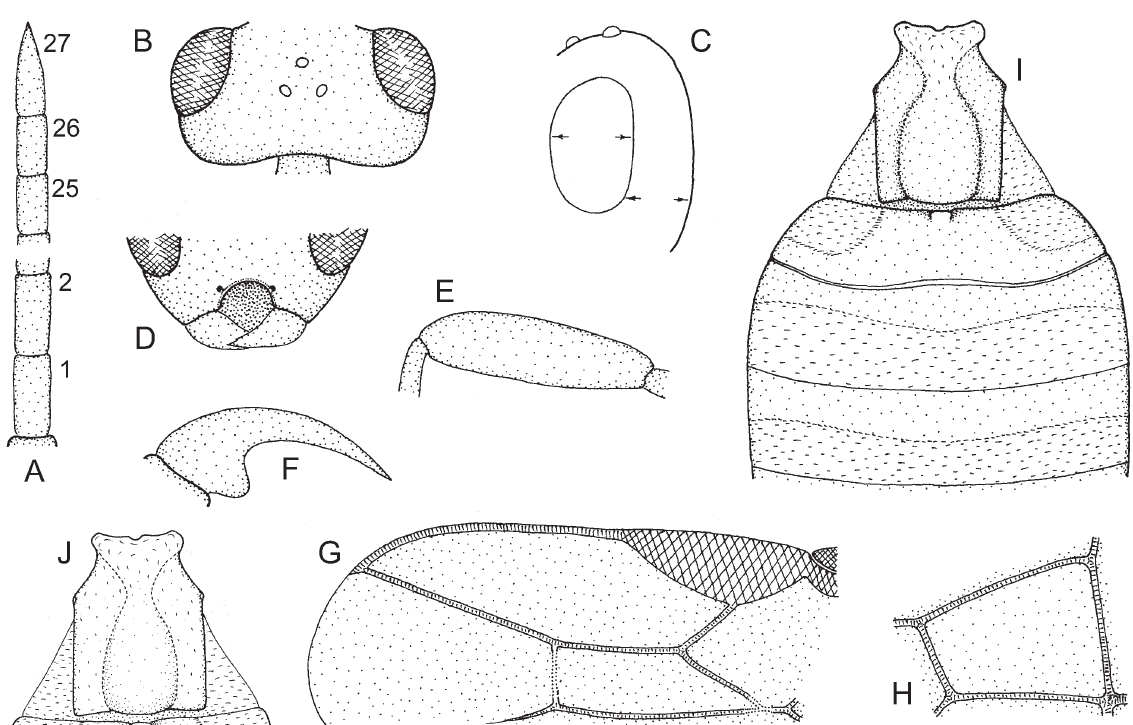
Fig. 65. Bracon ( Osculobracon ) osculator Nees, 1811 (A-I: ♀ neotype, B. bisignatus Wesmael, 1838, J: ♀ paralectotype). A . Flagelomeres 1-2 and 25-27. B . Head in dorsal view. C . Head in lateral view. D . Head in frontal view. E . Hind femur. F . Claw. G . Distal part of left forewing. H . First discal cell of left forewing. I . Tergites 1-4. J . First